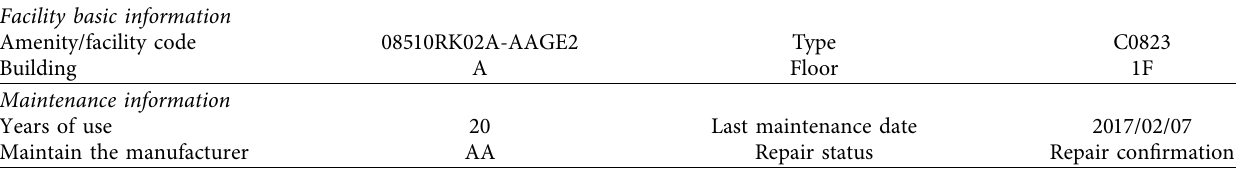
Table 5: Repair/maintenance traceability.